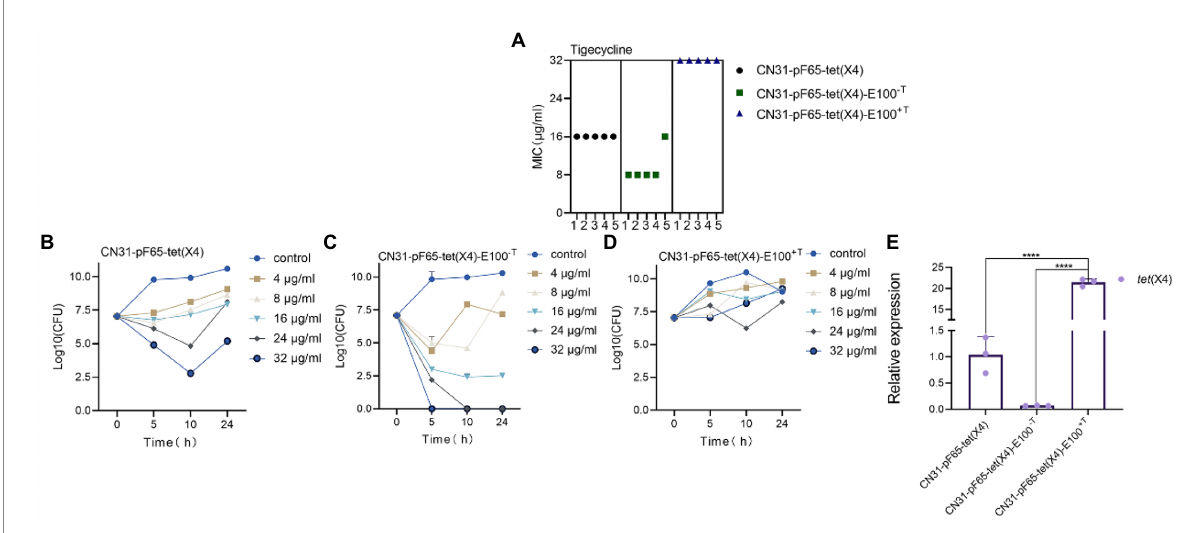
FIGURE 3 Evolved strains with different resistance levels to tigecycline under selective and non-selective pressure. (A) Comparison of MIC of tigecycline between ancestral and evolved strains. (B–D) Time-kill curve of tigecycline for the ancestral strain (B) , evolved strains without tigecycline (C) , and evolved strains with tigecycline (D) . (E) Comparison of the expression levels of tet (X4) gene between ancestral and evolved